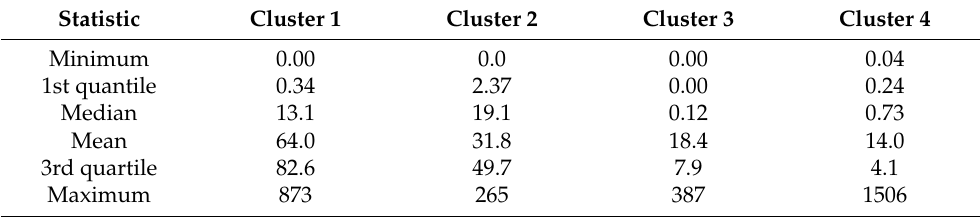
Table 6. Statistical summary of BC wb source contributions (ng/m 3 ).